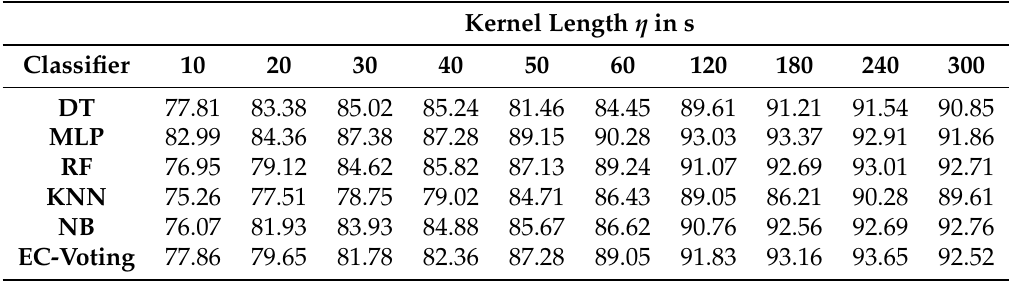
Table 5. Average accuracy (%) in Layer 1 for near-real time mode detection using GPS and spatial